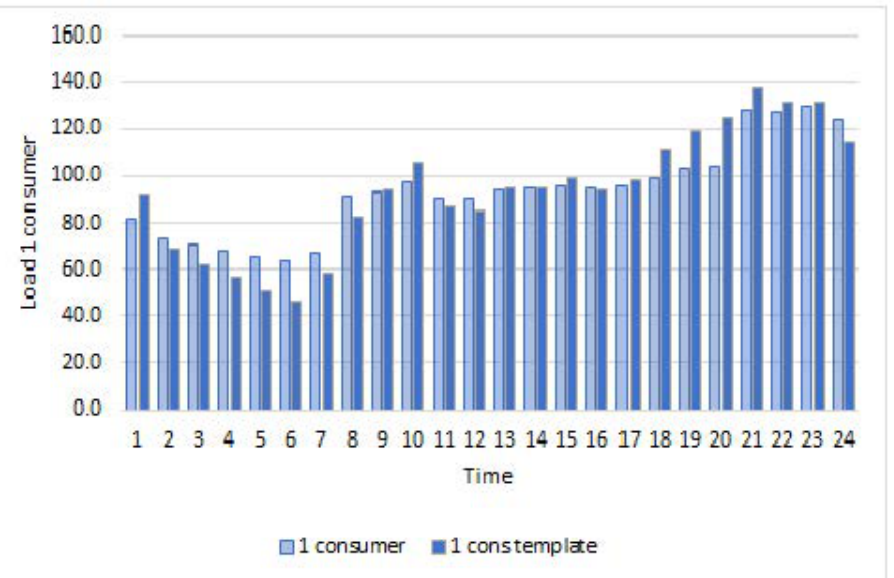
Figure 8. Load of Consumer 1 when its share when the share is 0.6 of the aggregated load.